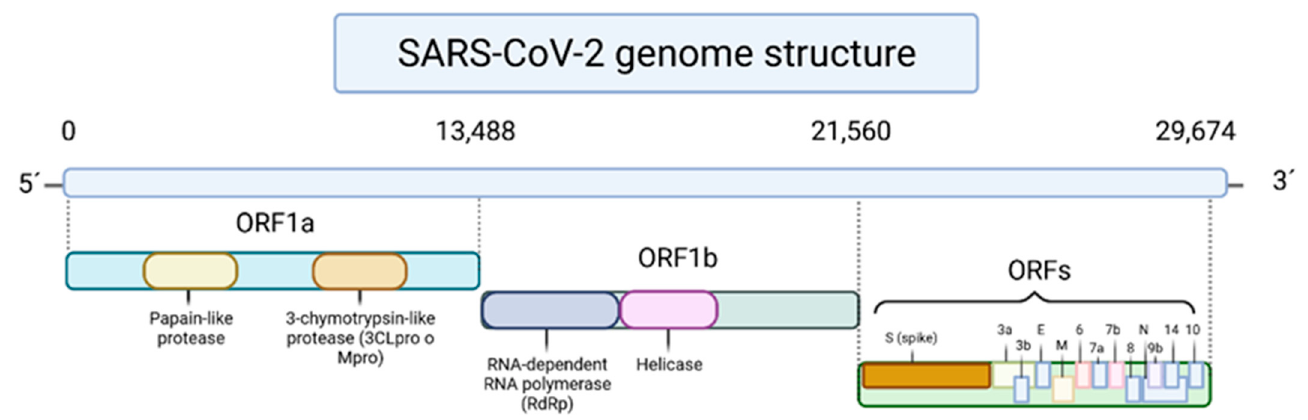
Figure 1. Genomic scheme of SARS-CoV-2 genome.